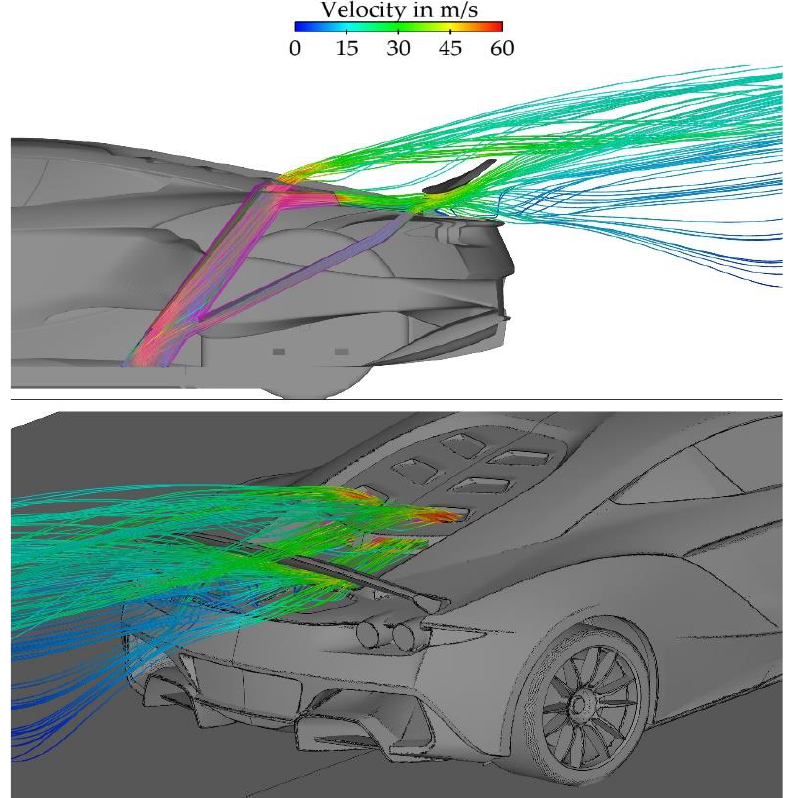
Figure 31. Pathlines of air exhausted from the main fan through the outlet ducts.